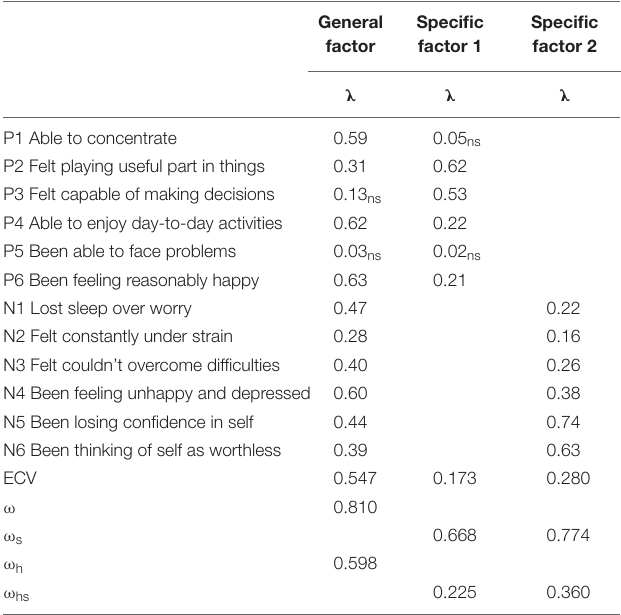
TABLE 2 | Factor loadings and variance composition for the bifactor model of the General Health Questionnaire (GHQ-12).